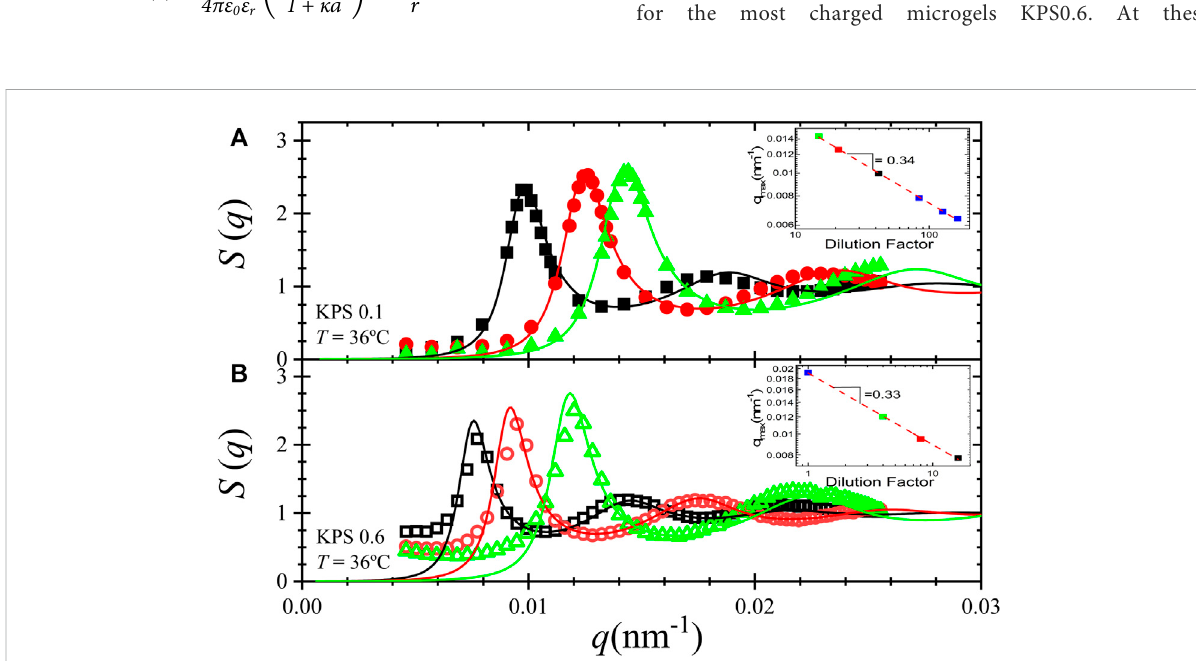
FIGURE 2 Measured static structure factors at 36 ° C for: (A) KPS0.1 system at n = 2.94 particles/µm 3 (black squares), 5.94 particles/µm 3 (red circles), and 8.85 particles/µm 3 (green triangles), (B) KPS0.6 system at n = 1.34 particles/µm 3 (black open squares), 2.39 particles/µm 3 (red open circles), and 5.06 particles/µm 3 (green open triangles), along with their HNC calculations (lines). Insets: Main peak position versus dilution factor used to prepare thesystemfromthestocksolution.Thedashedlineisalinear fi tinthelog-logpresentationwithaslopeof-0.34forKPS0.1systemand − 0.33for